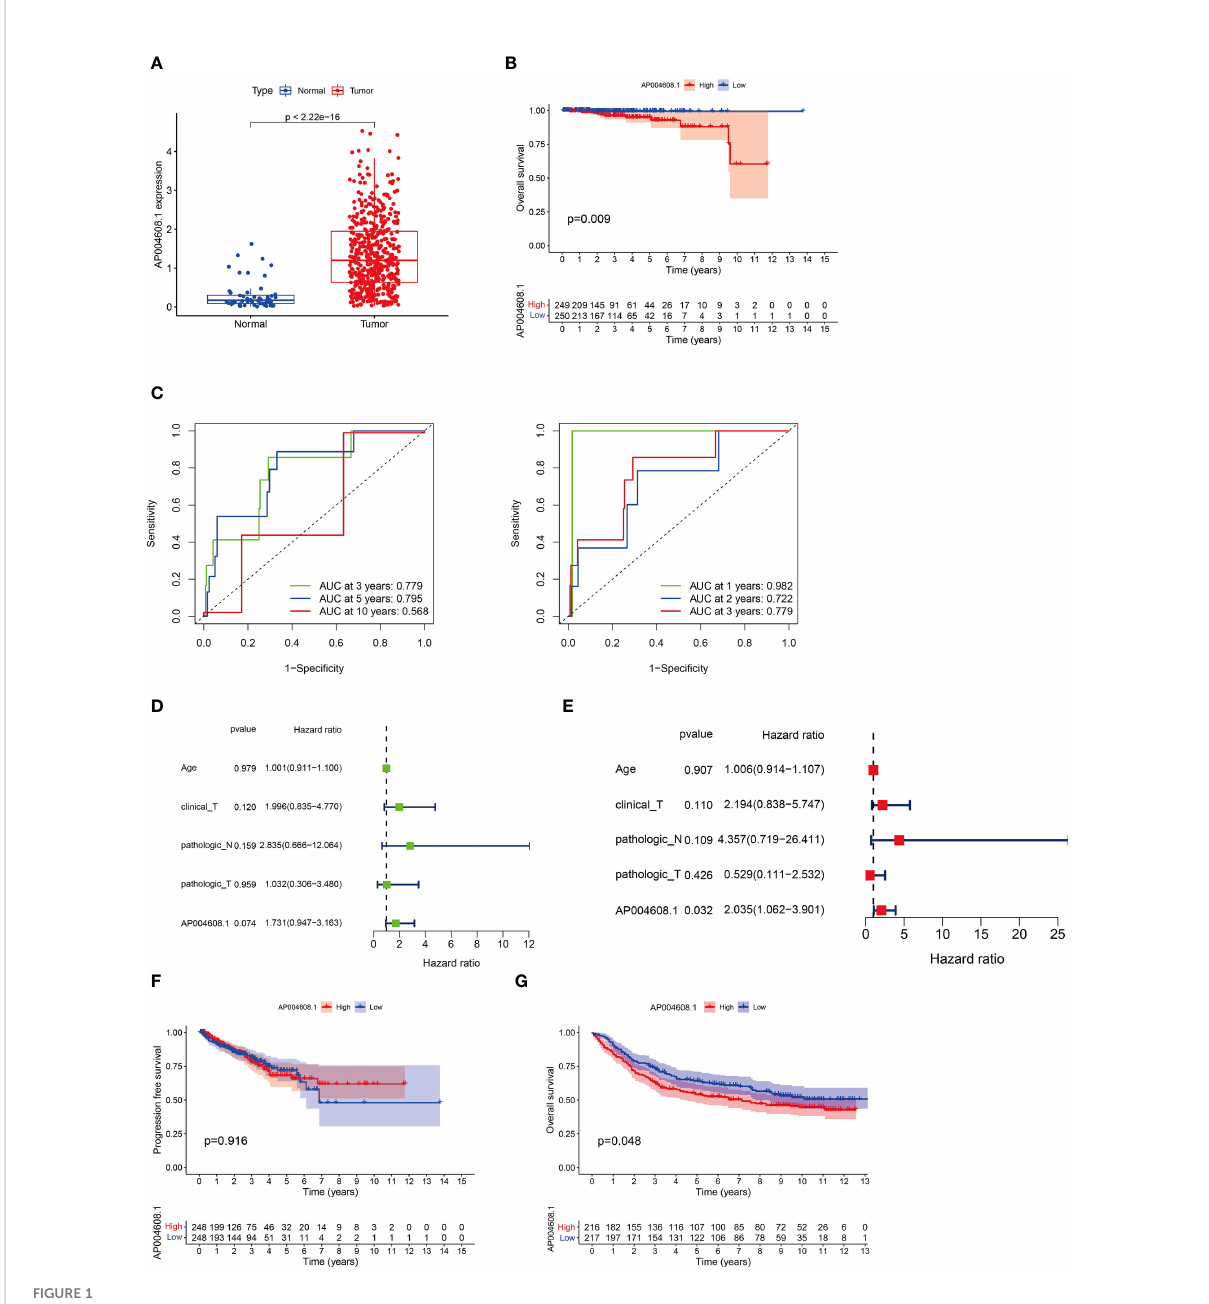
FIGURE 1 The clinical and prognostic value of AP004608.1 expression according to TCGA database. (A) AP004608.1 mRNA is highly expressed in PCa tissues in TCGA dataset. (B) The OS curves for the high and low expression groups of the AP004608.1 based on TCGA database. (C) The ROC curves that using the AP004608.1 showed the accuracy of predicting patient survival for large spans (3, 5 and 10 years) and small spans (1, 2 and 3 years) respectively. (D) Univariate screening of relevant prognostic genes for age, T-stage, M-stage, N-stage and AP004608.1expression. (E) Multifactorial screening of relevant prognostic genes for age, T-stage, M-stage, N-stage and AP004608.1 expression. (F) The PFS curves for the high and low expression groups of the AP004608.1. (G) The OS curves for the high and low expression groups of the AP004608.1 based on GEO